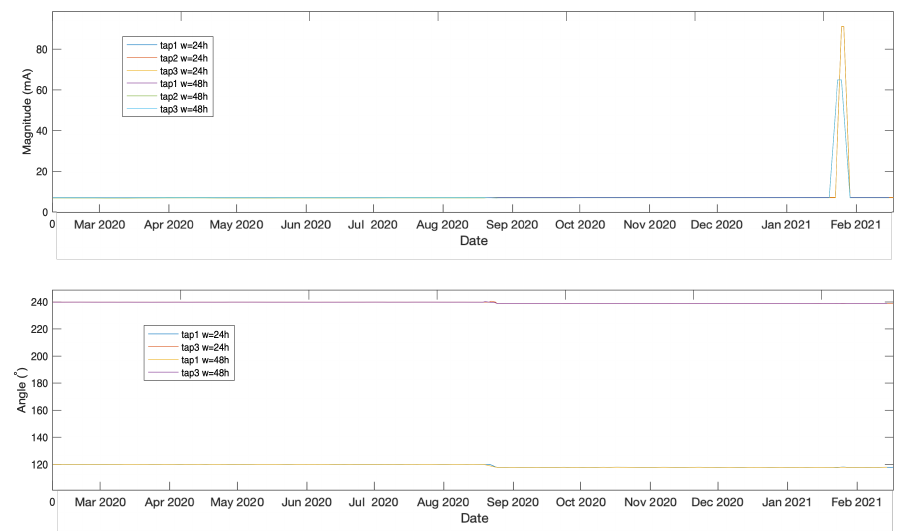
Figure 13. Moving average on the entire data